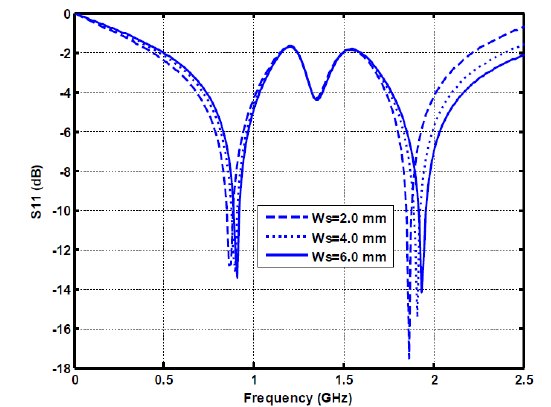
Figure 8: Variation of reflection coeflcient (dB) with frequency on varying width of microstrip ( W s ).